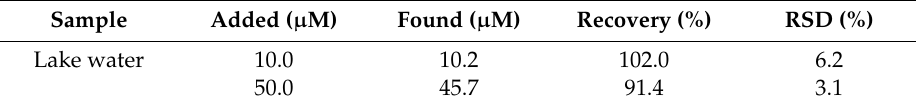
Table 1. Determination of cupric ions in a lake water sample ( n =